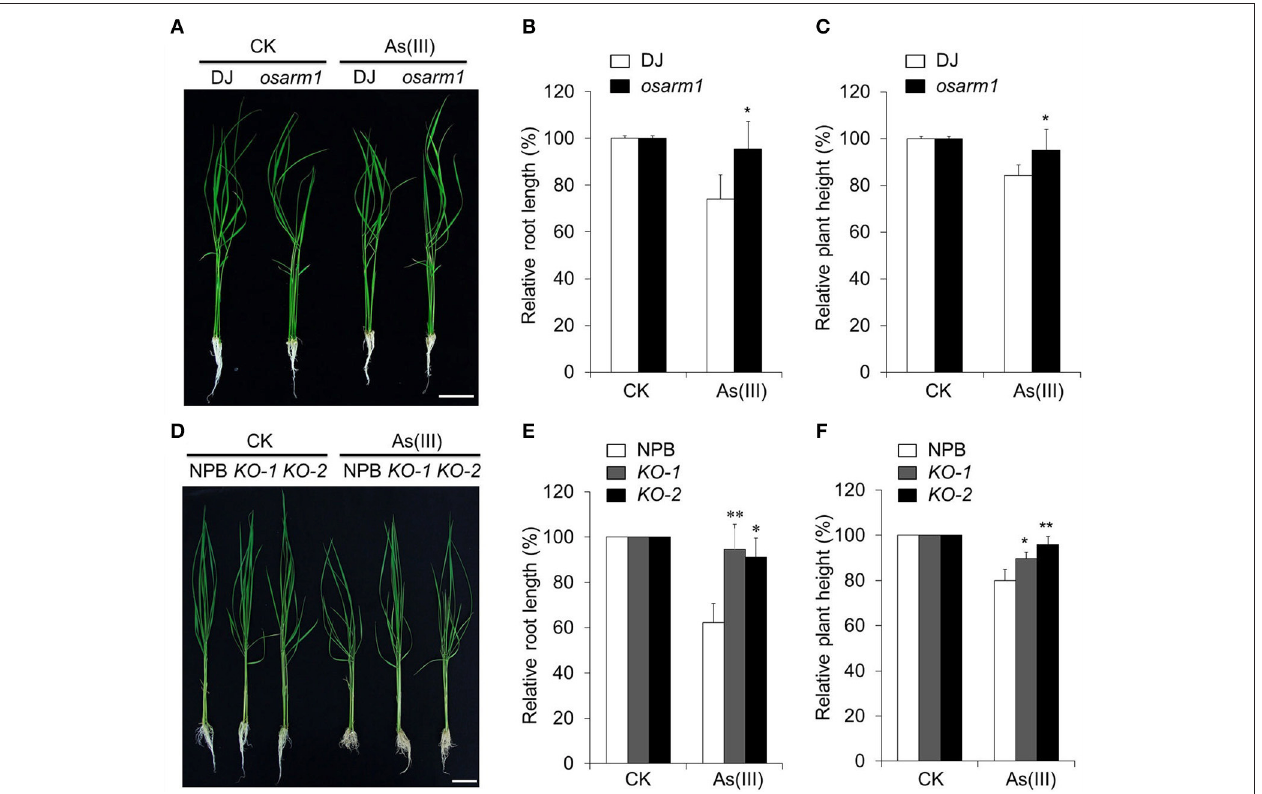
FIGURE 4 | Knockout of OsARM1 confers enhanced tolerance to As(III)-induced stress. (A) Phenotypes of 2-week-old wild-type DJ and osarm1 plants grown on Kimura B nutrient solution without (CK) or with 40 µ M As(III) for 7 days. (B,C) Relative root elongation (B) and relative plant height (C) of DJ and osarm1 plants after As(III) treatment in (A) . (D) Phenotypes of 2-week-old wild-type Nipponbare (NPB) and OsARM1-KO transgenic lines ( KO-1 and KO-2 ) grown on Kimura B nutrient solution without (CK) or with 40 µ M As(III) for 7 days. (E,F) Relative root elongation (E) and plant height (F) of Nipponbare and OsARM1-KO s ( KO-1 and KO-2 ) after As(III) treatment in (D) . The experiments were repeated three times (biological replicates), and > 10 plants were used for each genotype in a single experiment. Data are means ± SD ( n = 30) calculated from three independent experiments. Asterisks indicate significant differences from wild type (* P < 0.05; ** P < 0.01 by Student’s t -test). Bars = 4 cm.